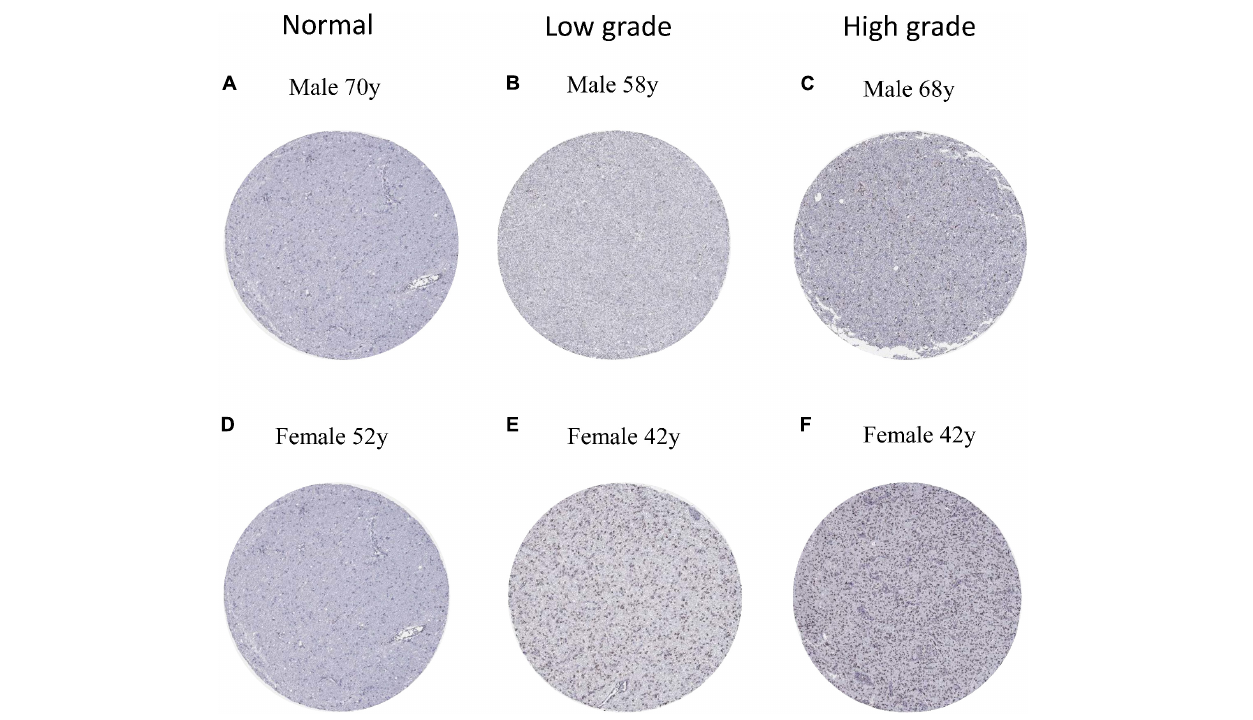
FIGURE 7 | Protein levels of ESPL1 in normal and glioma tissues by immunohistochemistry based on the Human Protein Atlas (staining: medium; intensity: moderate; quantity: > 75%). (A,D) The expression of ESPL1 in normal brain tissues of men and women. (B,E) The expression status of ESPL1 in low-grade gliomas in men and women. (C,F) The expression status of ESPL1 in high-grade gliomas in men and